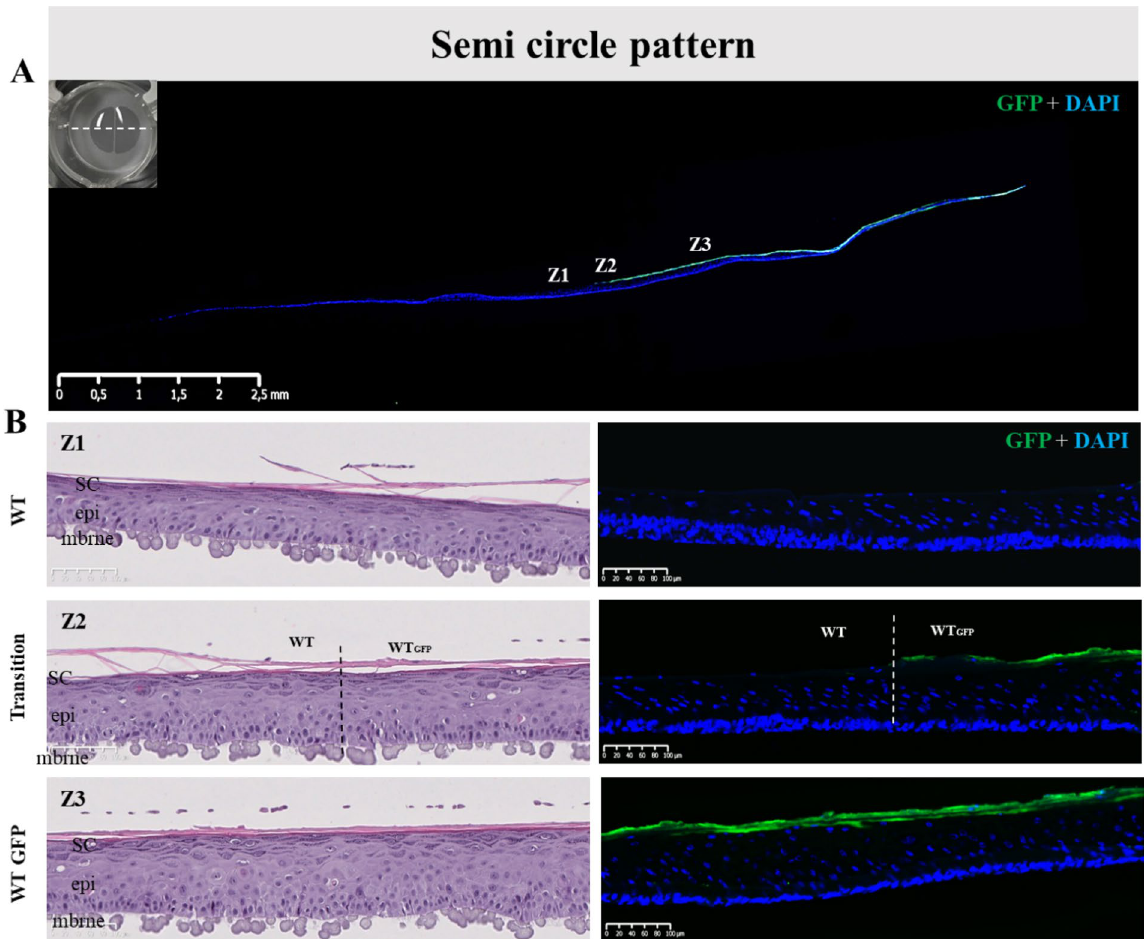
Figure 3. Histology of pattern bioprinted epidermis comprised of two distinct cell populations. ( A ) Lateral view of the reconstructed skin stained for GFP (green) and cell nuclei (DAPI, blue) at day 14 post-reconstruction. Indicated positions Z1–3 correspond to ( B ) H&E and immunofluorescence stained sections Z1–3, whereby Z1 is from the WT printed cell half, Z2 is the WT/WT-GFP cell interface, and Z3 is representative of the WT-GFP printed half. The H&E images (left) show no difference in gross morphology, while the immunofluorescence images (right) reveal no GFP staining on the WT cell side of the model, a clear demarcation where the WT and WT-GFP halves meet, and a consistent GFP signal in the WT-GFP printed half, demonstrating the model patterning to be stable across 14 days of culture. Images representative of 10 separate